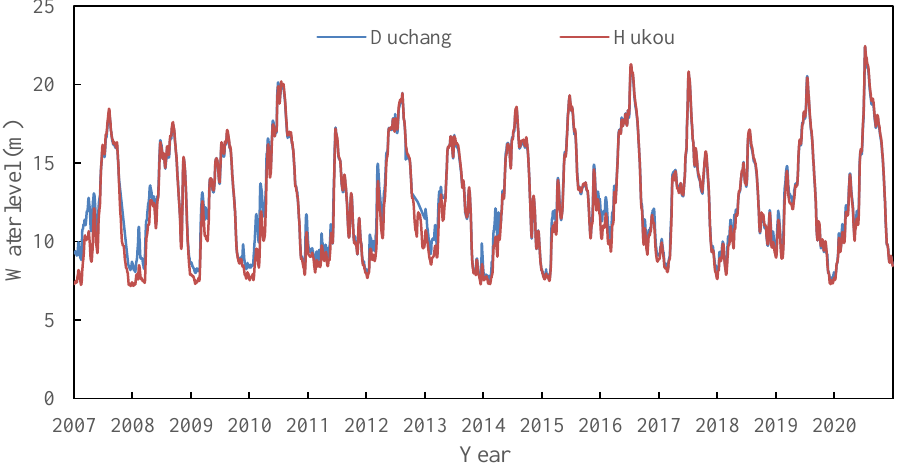
Figure 5. Comparison of water level between the Hukou station and the Duchang station from 2007 to 2020: the red line represents water level of the Hukou station, and the blue line represents water level of the Duchang